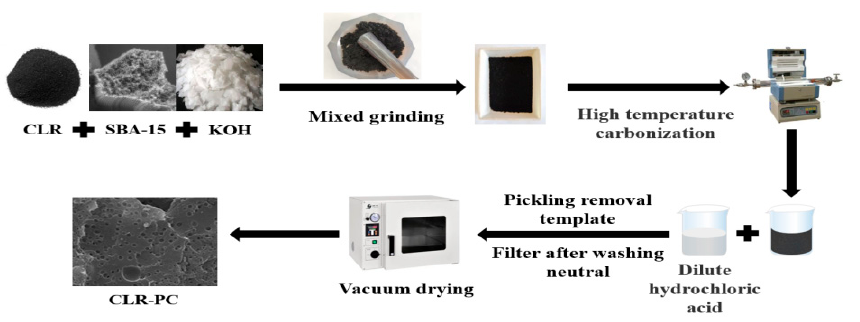
Figure 1. Schematic diagram of preparation of porous carbon based on coal liquefaction residue.